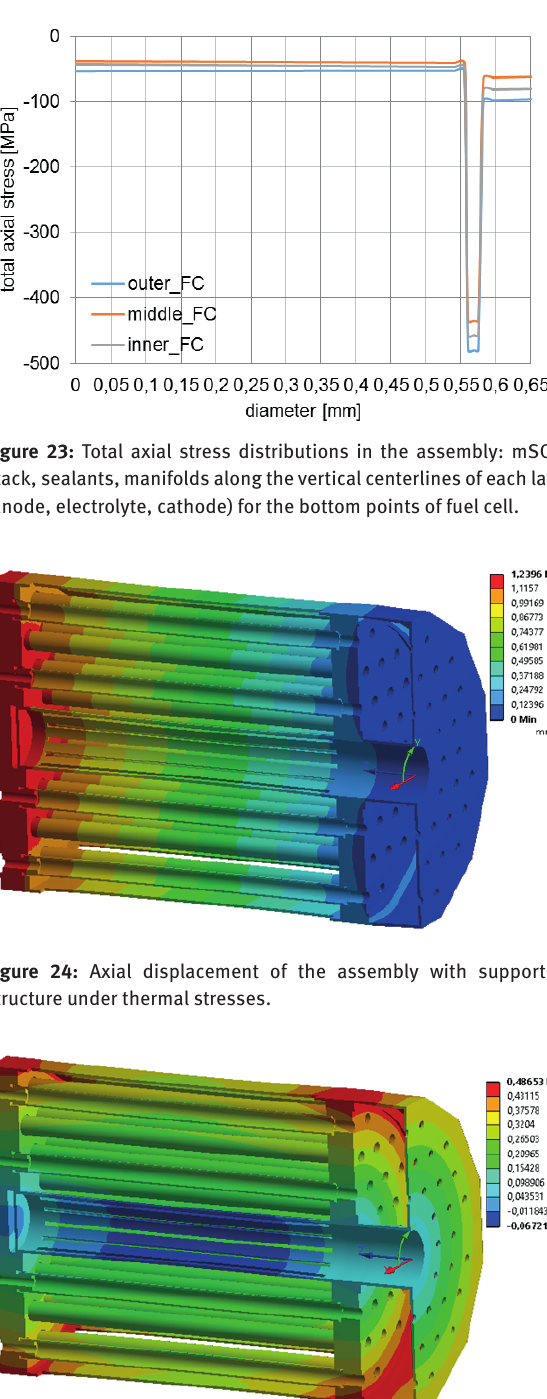
Figure 22: Total axial stress distributions in the assembly: mSOFC stack, sealants, manifolds along the vertical centerlines of each layer (anode, electrolyte, cathode) for the top points of fuel cell. values compared to the stresses in the fuel cell stack equal to -71 to 500 MPa indicated the need of changing the structure from the dodecagon into the cylindrical.